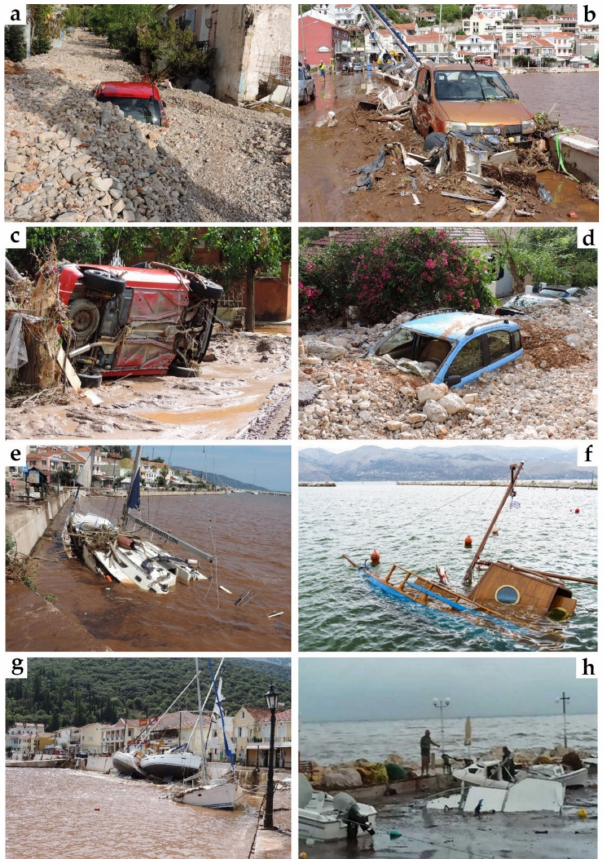
Figure 12. Characteristic images from the impact of Ianos Medicane on road vehicles in ( a – d ) (examples from Assos and Agia Efimia in Cephalonia) and boats ( e – h ) (examples from Agia Efimia, Lixouri and Ithaki).